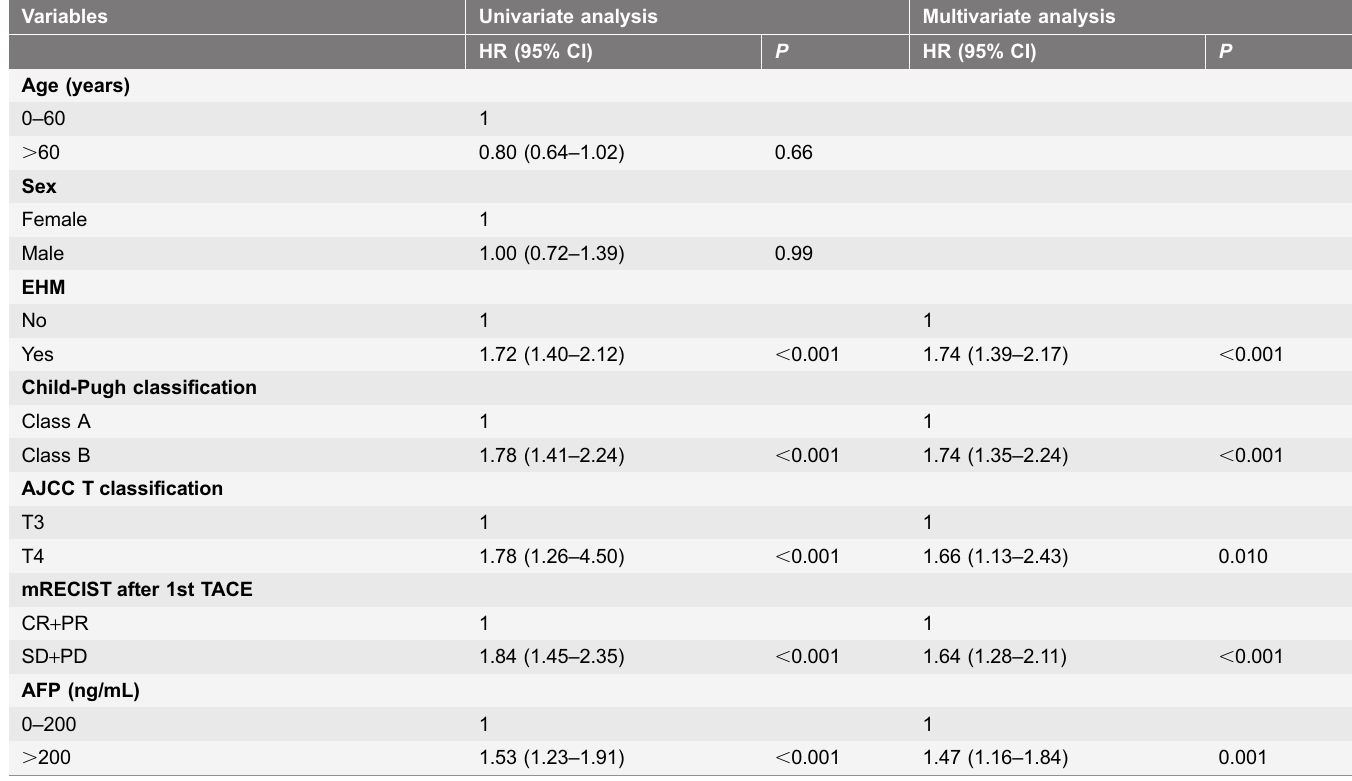
Table 3. Univariate and multivariate analyses of predictive factors for overall